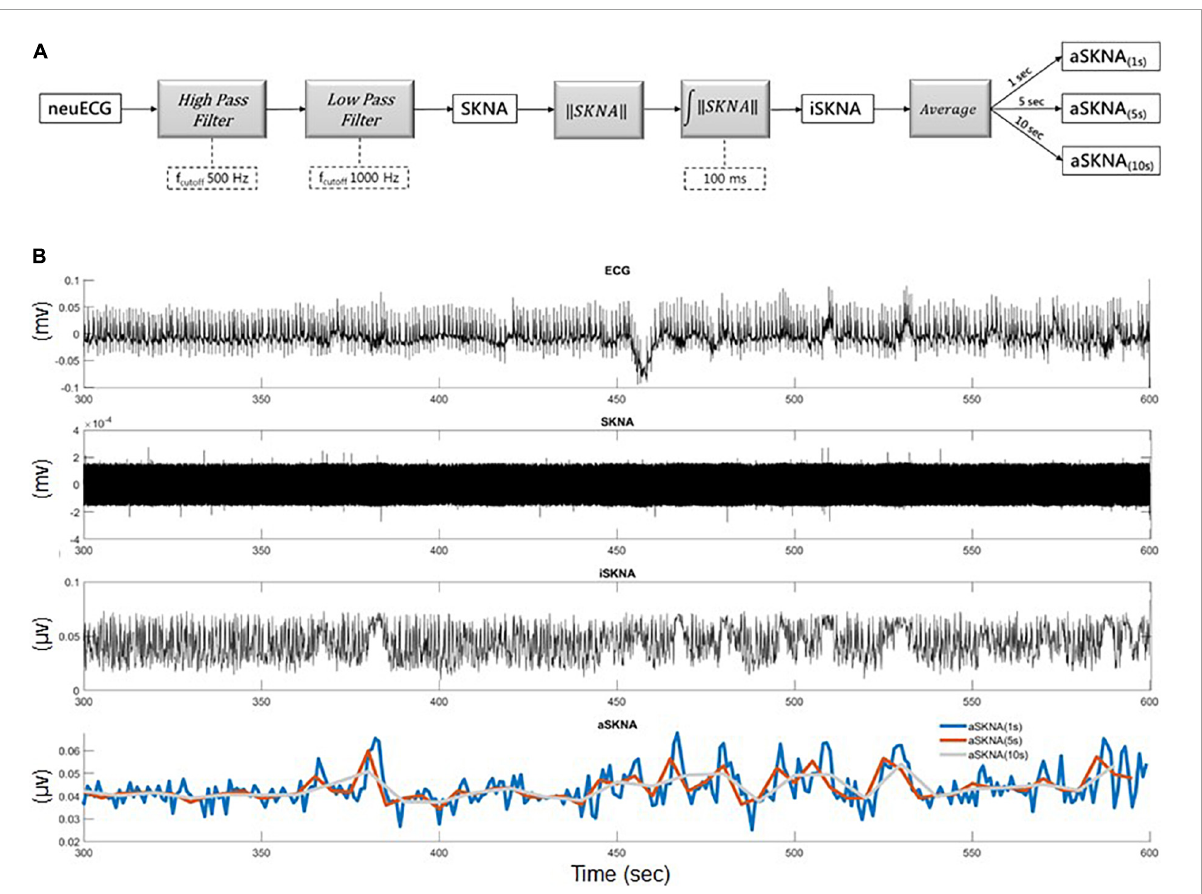
FIGURE1 (A) The framework for skin nerve activity (SKNA) extraction: neuECG signal was originally recorded for 10 min sampling at 10,000 Hz and the neural activity signal was extracted by a 500-Hz high-pass filter and then a 1,000 Hz low-pass filter to remove the ECG signal. (B) Illustration of the extracted iSKNA (integrated SKNA) and aSKNA (averaged SKNA) signals: (1) the recorded neuECG signal; (2) the SKNA signal after high-pass filtering; (3) the iSKNA signal was derived by rectifying and summing up the SKNA signal with a non-overlapping 100 ms time window; (4) the iSKNA signal can be further averaged for different durations (e.g., 1, 5, or 10 s) to represent the dynamics of the sympathetic system interacting with the parasympathetic system for different time